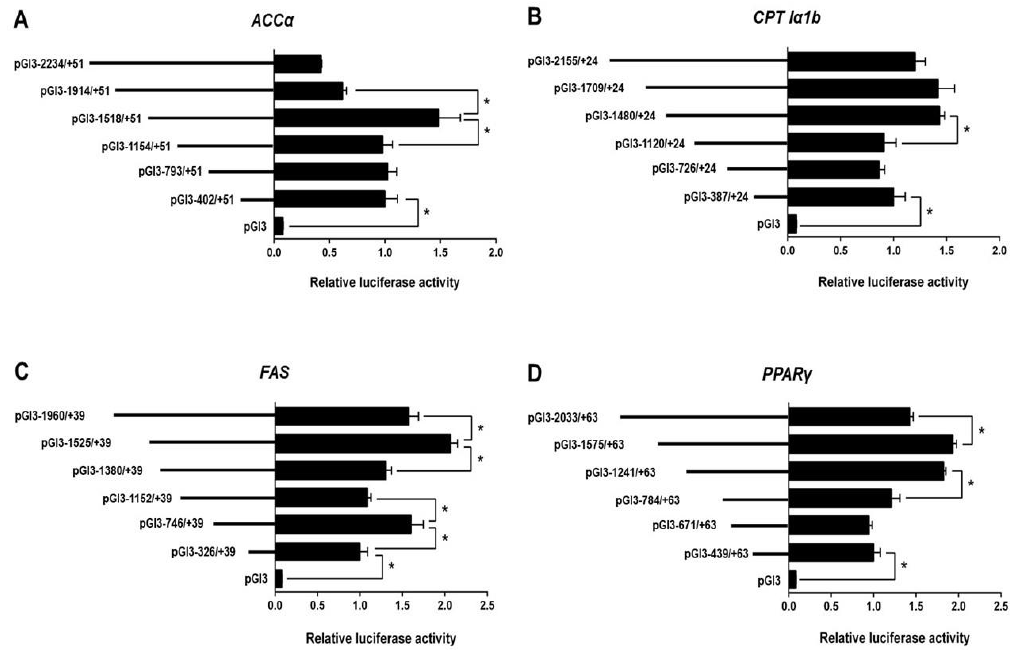
Figure 1. 5 ′ unidirectional deletion assays of the promoter regions of ACC α (acetyl-CoA carboxylase alpha), CPT I α 1b (acetyl-CoA carboxylase alpha), FAS (fatty acid synthase,), and PPAR γ (peroxisome proliferator-activated receptor gamma) of yellow catfish. ( A ) Assays for the ACC α promoter; ( B ) assays for the CPT I α 1b promoter; ( C ) assays for the FAS promoter; ( D ) assays for the PPAR γ promoter. Values mean the ratio of activities of firefly to Renilla luciferase , normalized to the control plasmid. Results are shown as mean ± standard error of mean (SEM) ( n = 3). Asterisk (*) means significant differences between two groups ( p < 0.05).